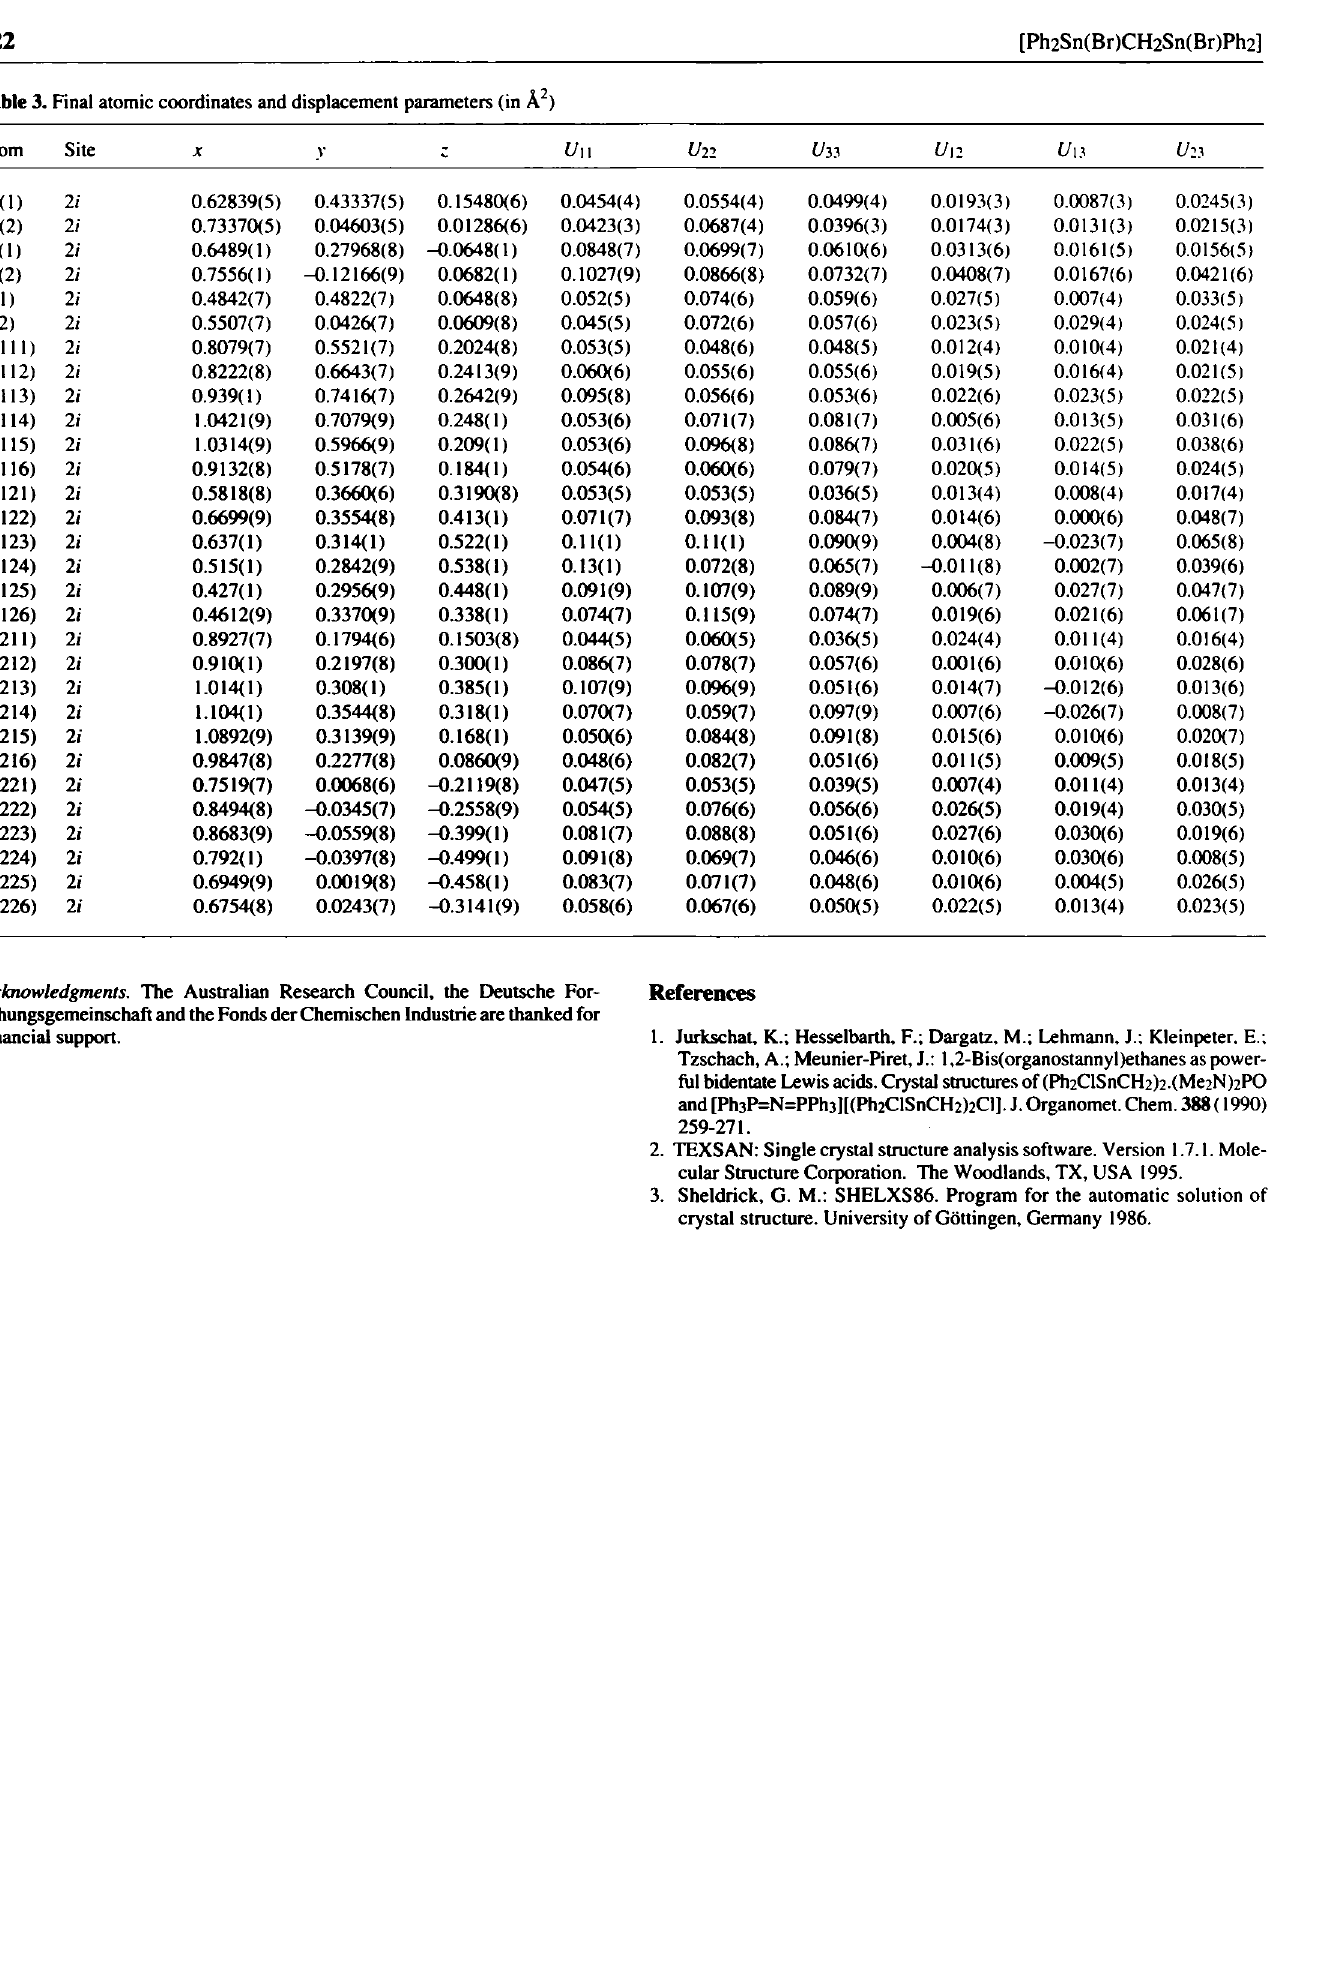
Table 3. Final atomic coordinates and displacement parameters (in Â^)